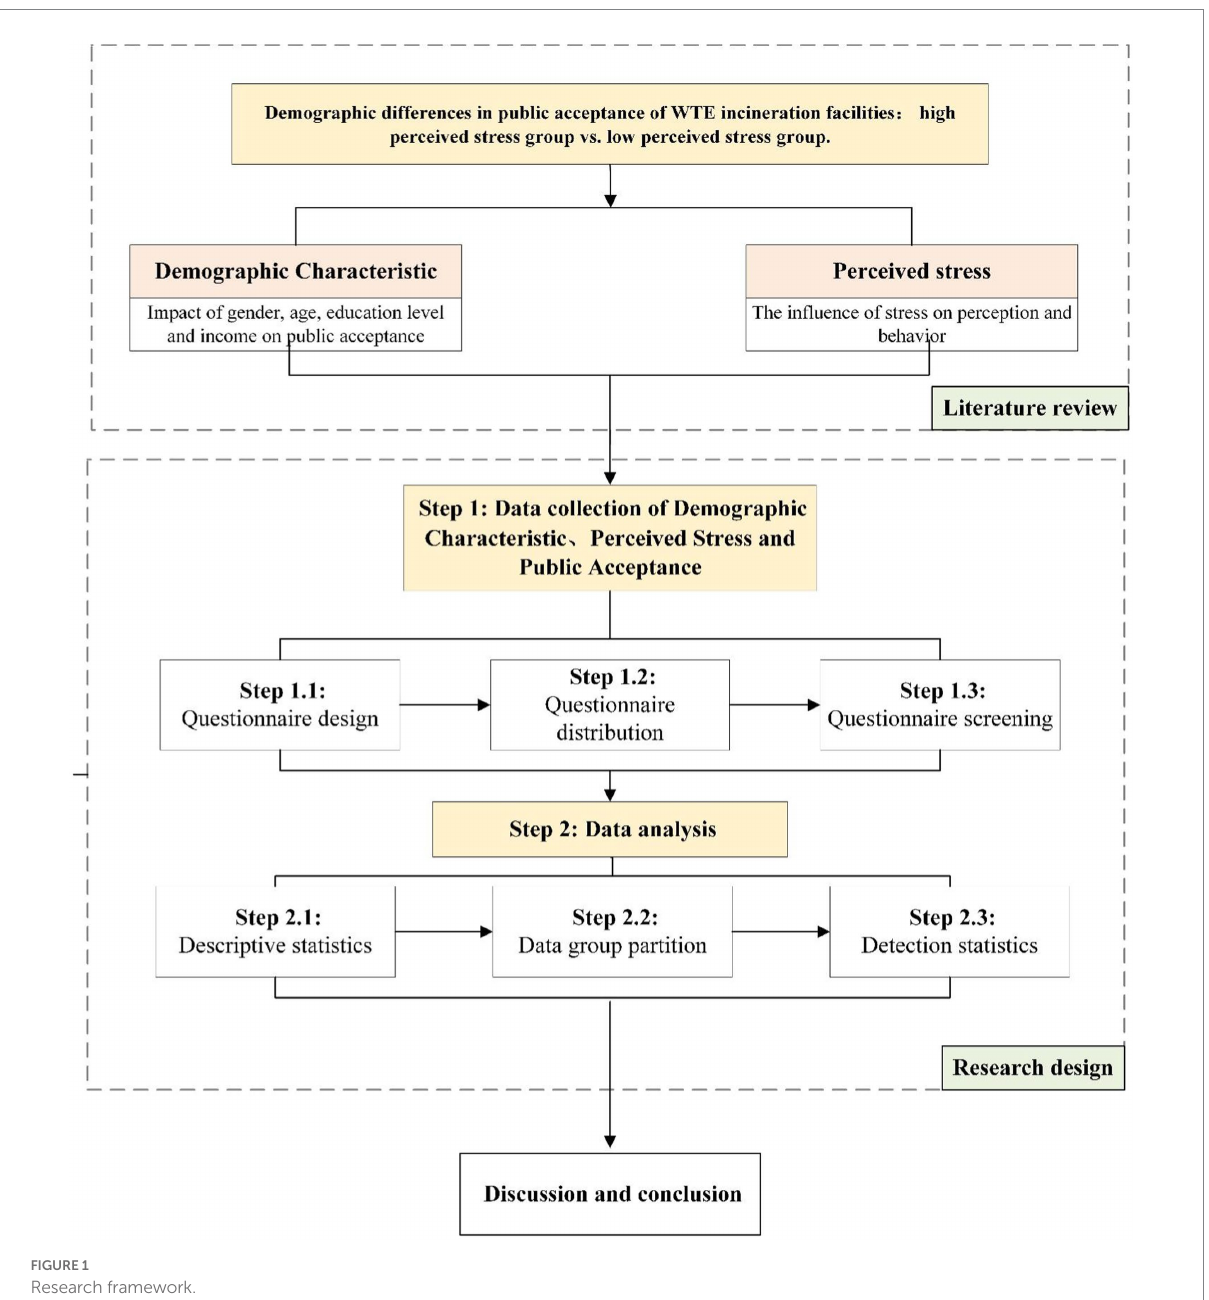
FIGURE 1 Research